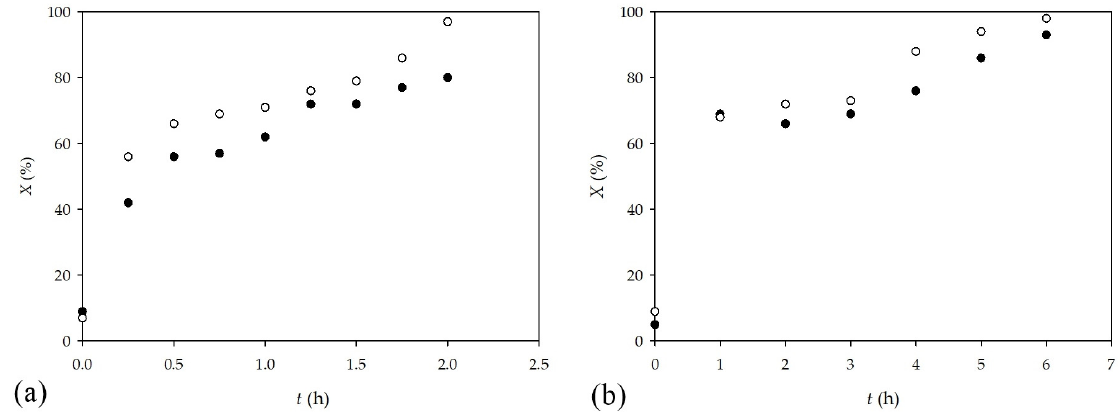
Figure 6. The dynamic change of conversion for ( a ) free-base porphyrin and ( b ) Mn(III) porphyrin ( ◦ anionic, • cationic) obtained by UHPLC analysis.